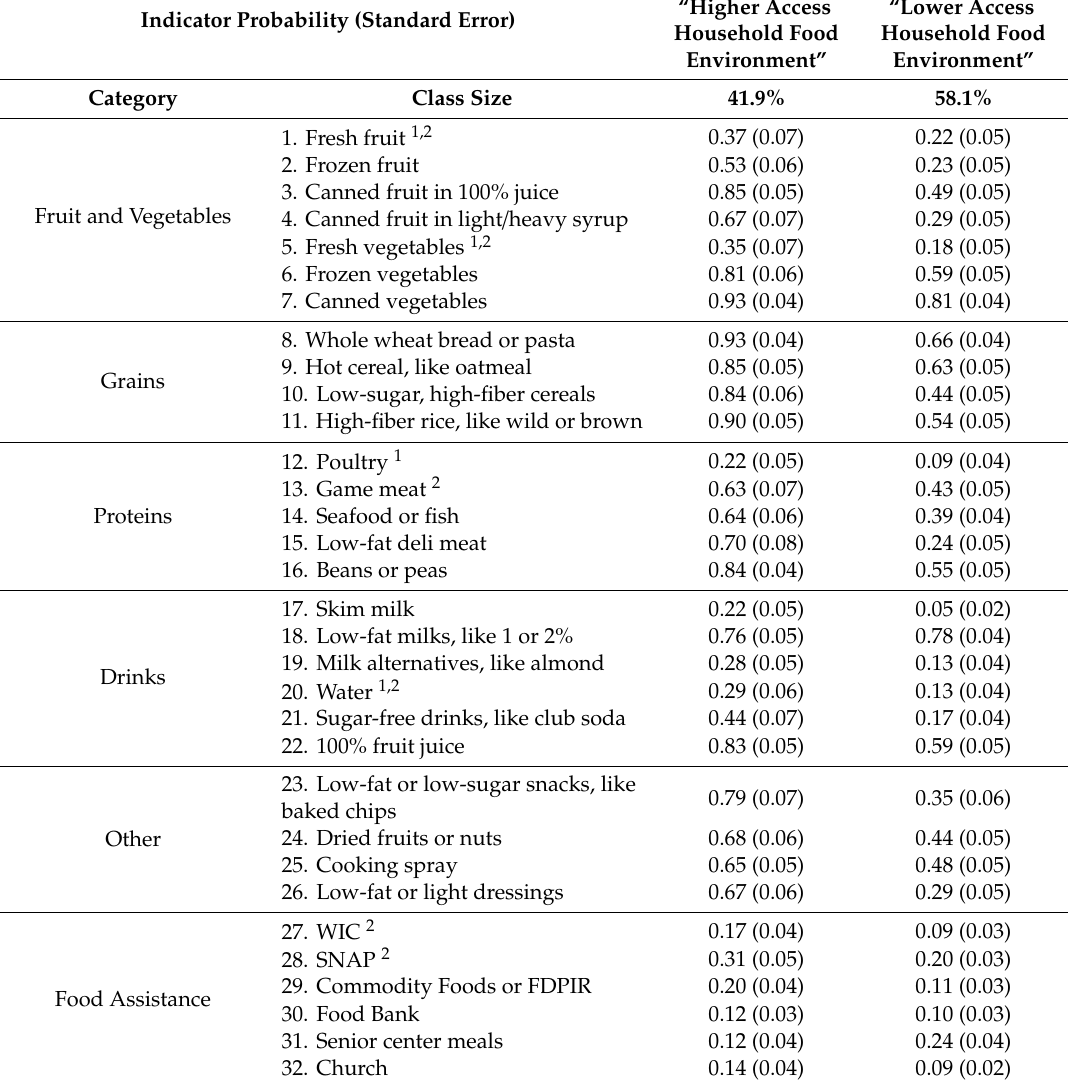
Table 2. Probability of healthy food getting, and food assistance participation given household food environment class membership among three Native American communities ( n = 300) from the Midwest and Southwest,